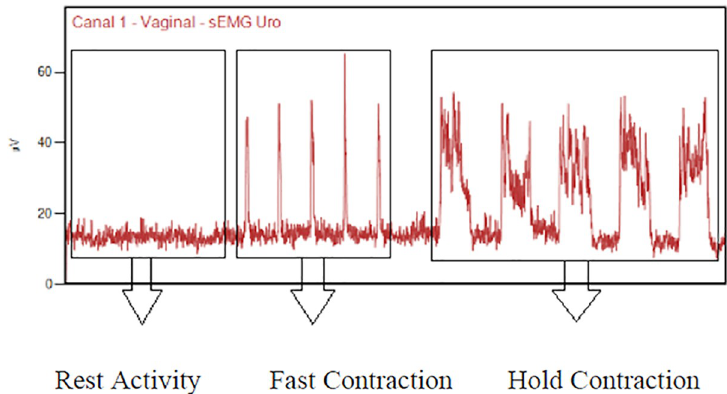
Fig 1. Modified Glazer Protocol plots showing rest activity and fast and hold